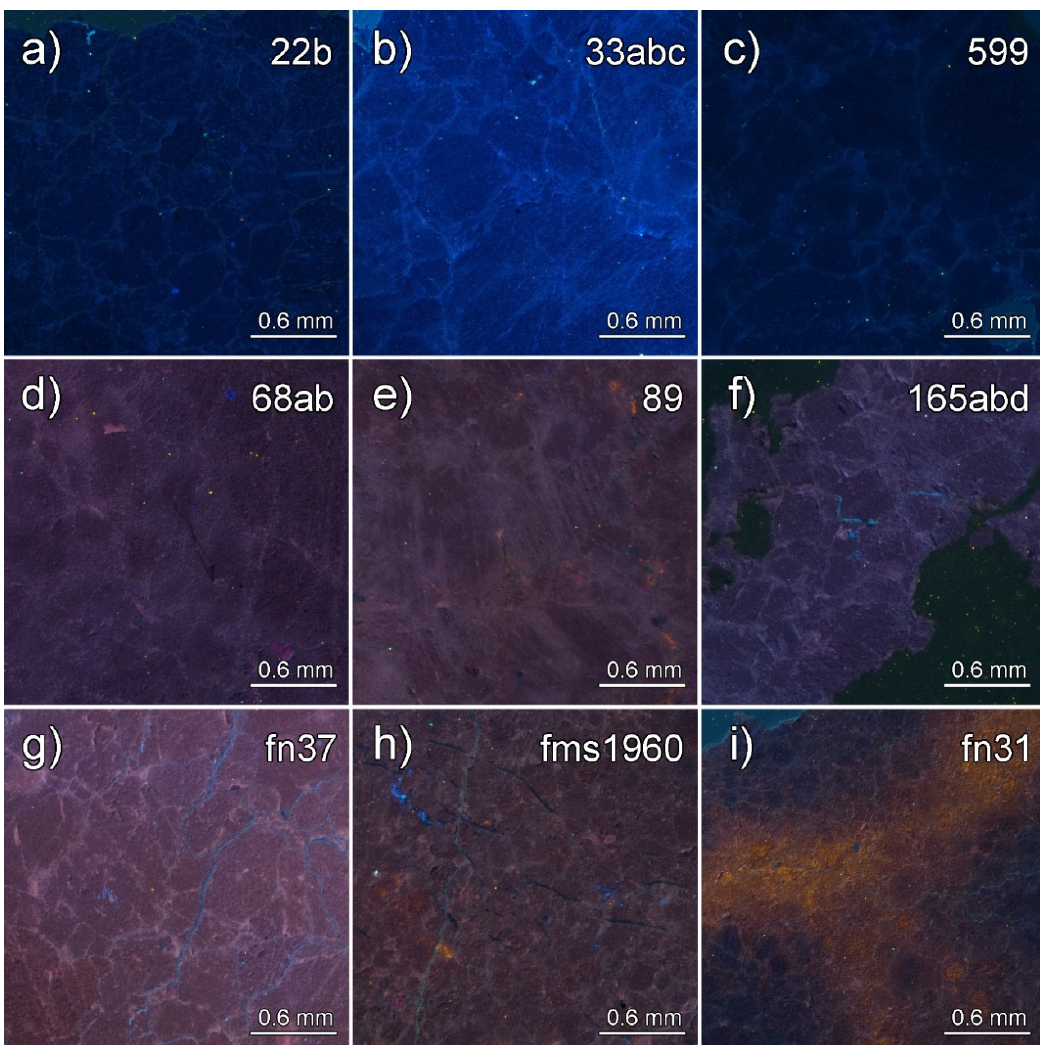
Figure 6. Petrographic images of thin sections of some sampled marble fragments viewed under CL. With ascribed slab ( a ) 22b, slab VII-15 and ( b ) 33abc, slab V-17; without ascribed slab ( c ) 599, ( d ) 68ab, ( e ) 89, ( f ) 165abd and ( g ) fn37; fragments not assigned to the F.U. ( h ) fms1960 and ( i )